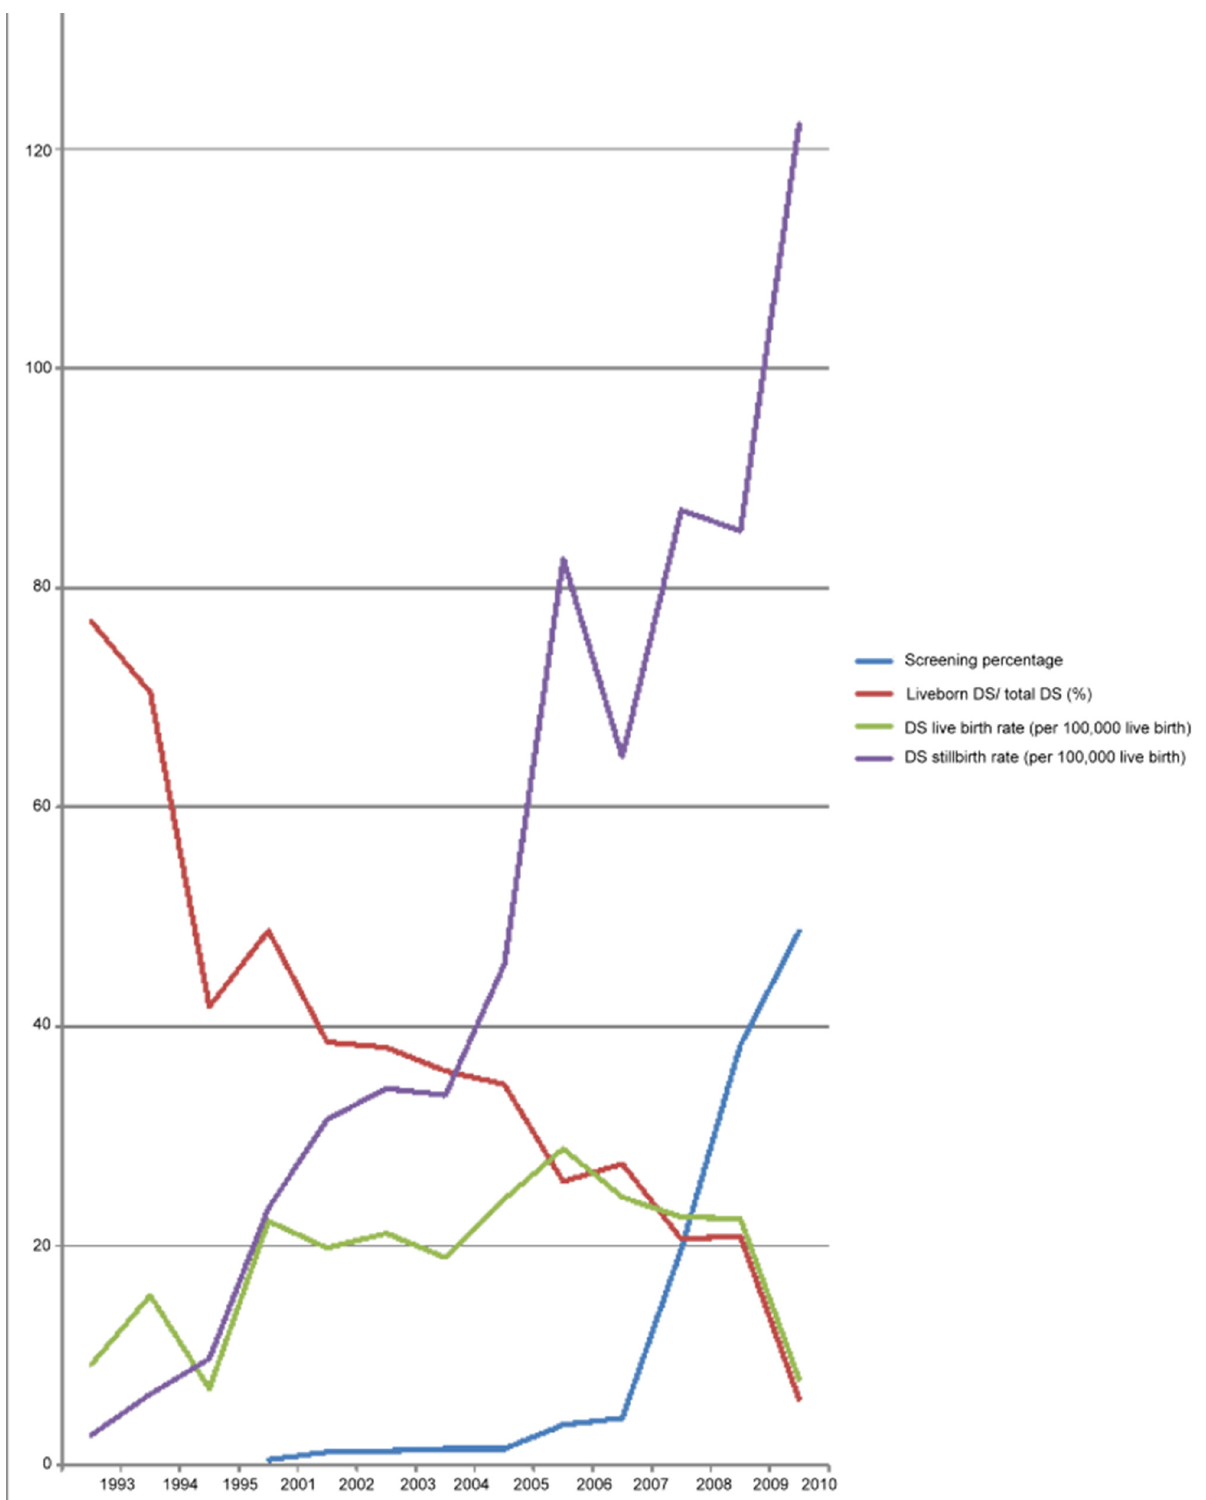
Figure 1. Down syndrome (DS) live birth rates. The Taiwanese DS live birth ratio dropped from 48.74% of all fetuses with DS in 2001 to 25.88% in 2006, when first-trimester DS screening was widely introduced. The rate dropped further, to 20.64%, in 2008, when the second-trimester quadruple test was implemented in Taiwan. By 2010, the live birth rate was 7.79 per 100 000 live births. doi: 10.1371/journal.pone.0075428.g001 PLOS ONE |